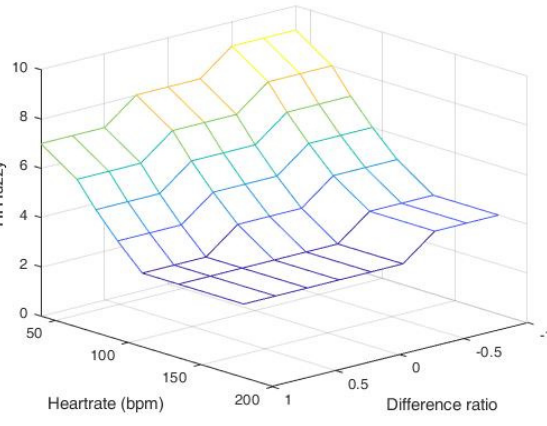
Figure 14. Output of the HR_Fuzzy parameter with heart rate and difference ratio.